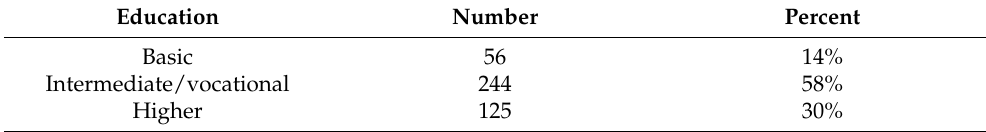
Table 4. Structure of